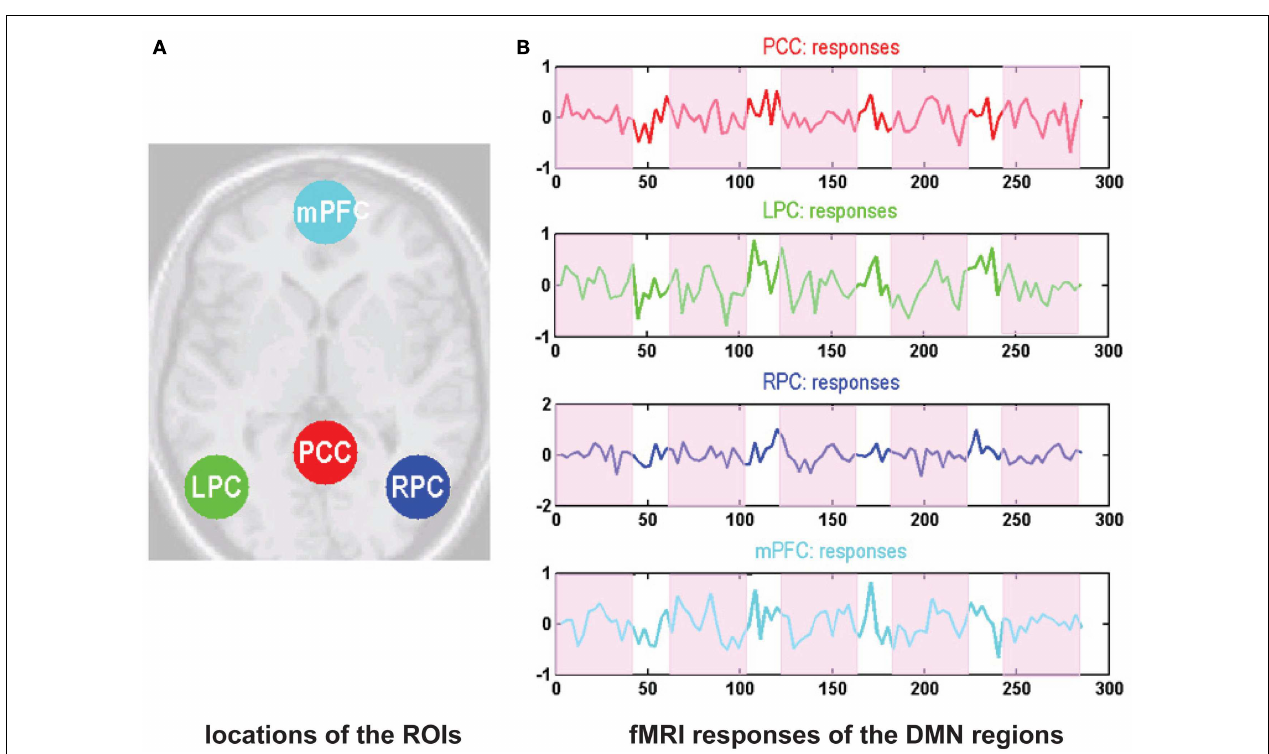
SPM analysis of the default mode components. (B) Regional responses correspond to the principal eigenvariate of all voxels within 6mm of the region’s center. Abbreviations: mPFC, medial prefrontal cortex; PCC, posterior cingulate cortex; RPC, right lateral parietal cortex; LPC, left lateral parietal cortex.